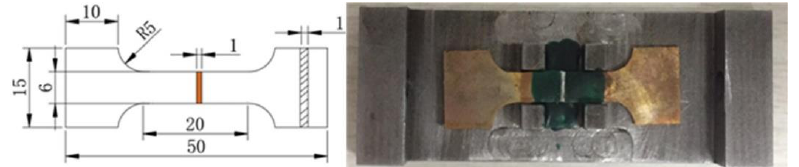
Figure 9. The design and the actual sample prepared for further tests.